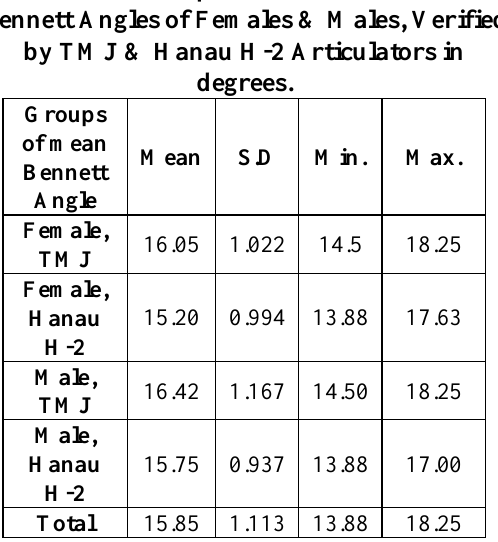
Table 5: Descriptive Statistics of Mean